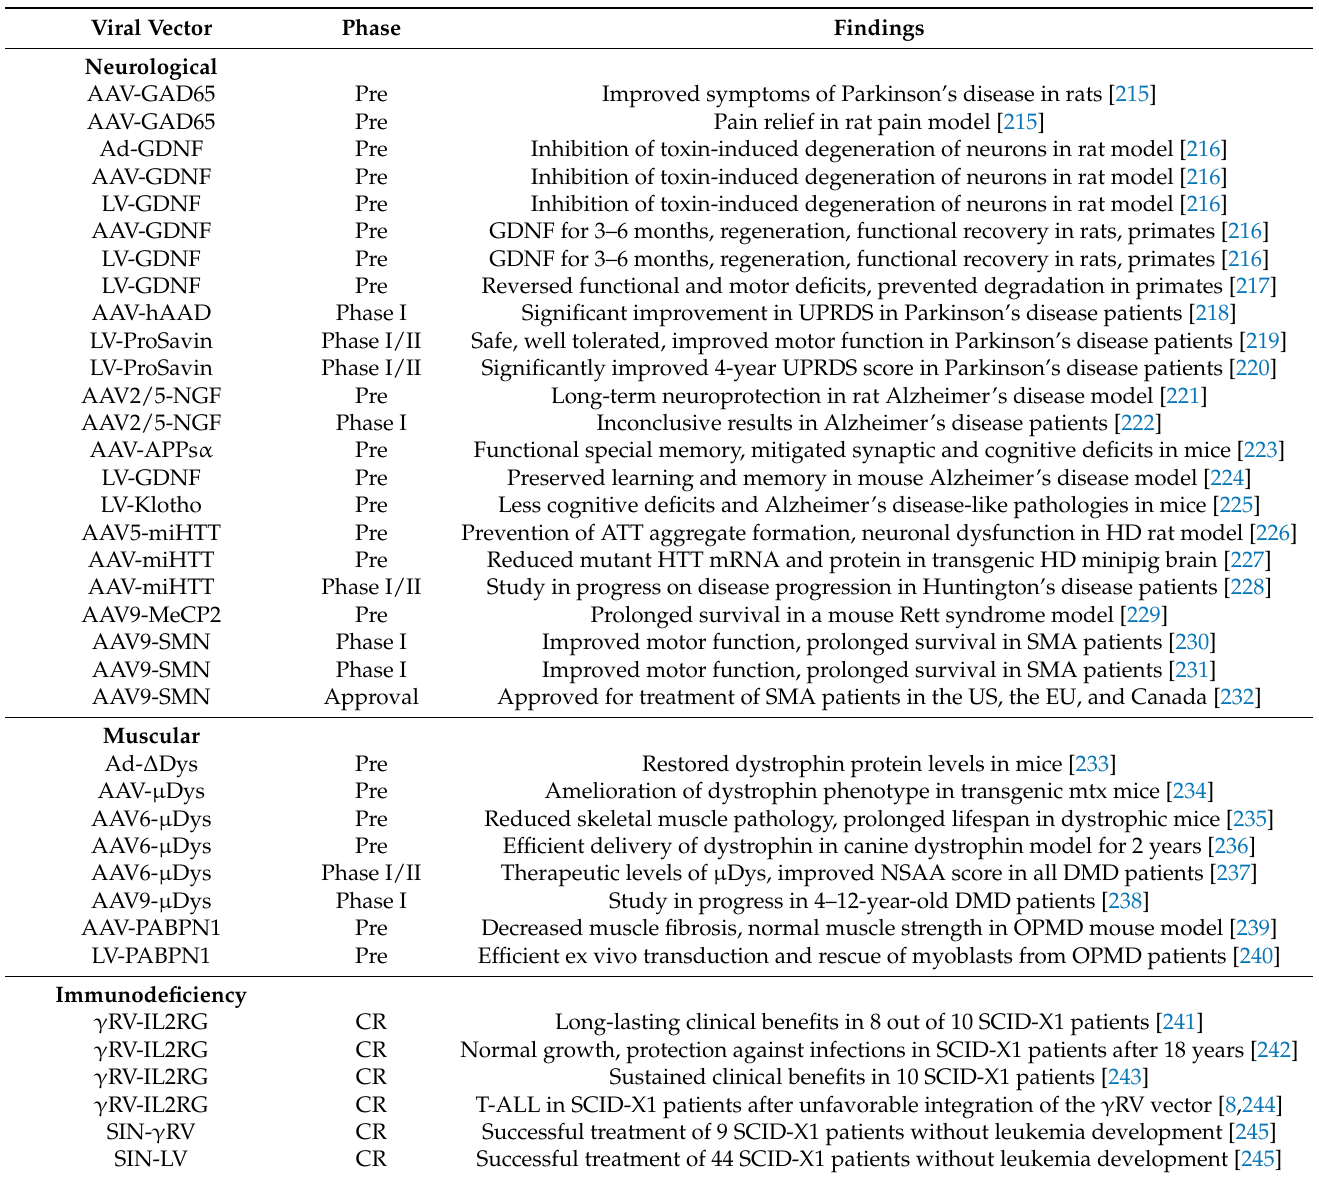
Table 4. Preclinical and clinical examples of viral vectors applied for neurological disorders, muscular diseases, and